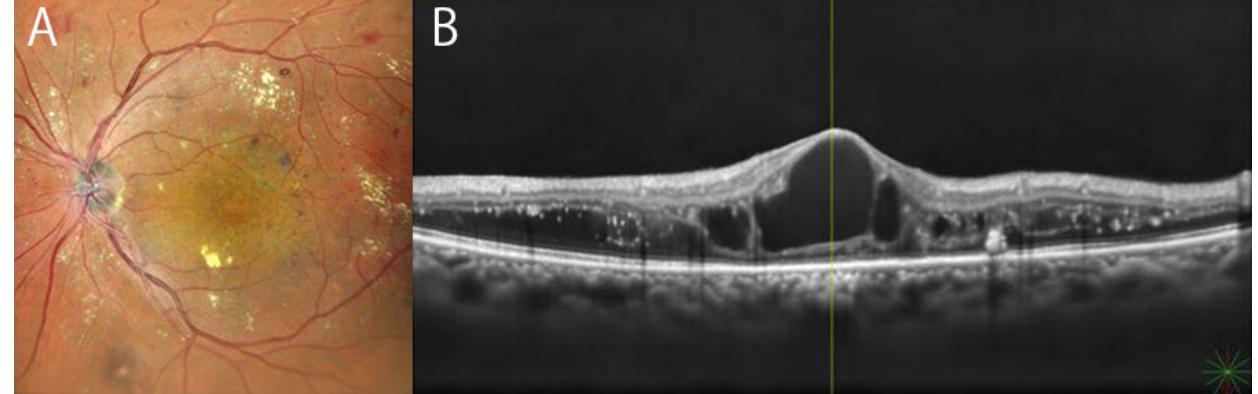
Figure 2. Posterior fundus and macular OCT images of diabetic macular edema of 62-year-old